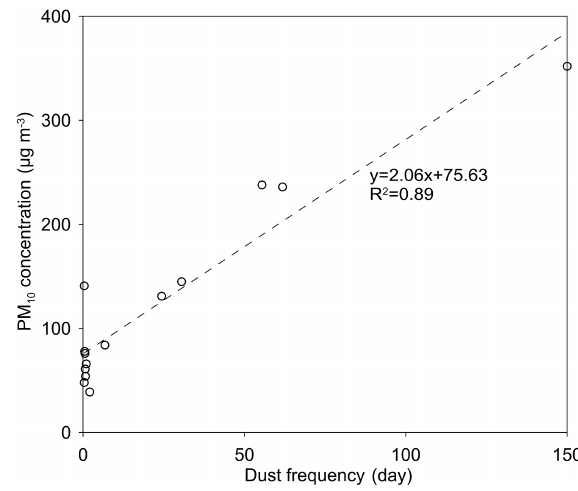
Figure 11. Relationship between PM 10 concentration and dust day frequency in Xinjiang Province. Each point represents data aver- aged across 2000 to 2013 at one